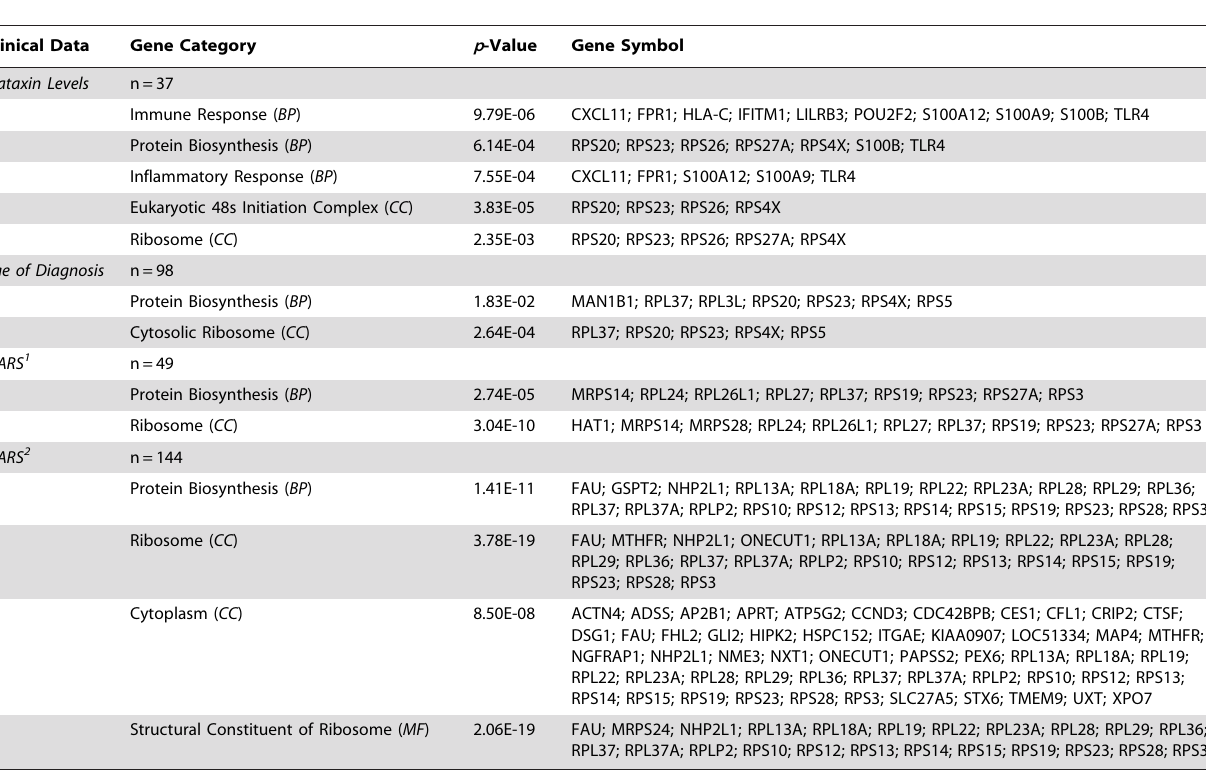
Table 2. Potential biomarkers of FRDA: gene associations to clinical data based on differential